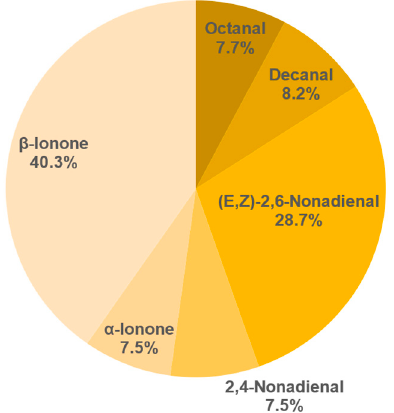
Figure 15. Percentage of OAV of each compound in the total aroma of sample 687.